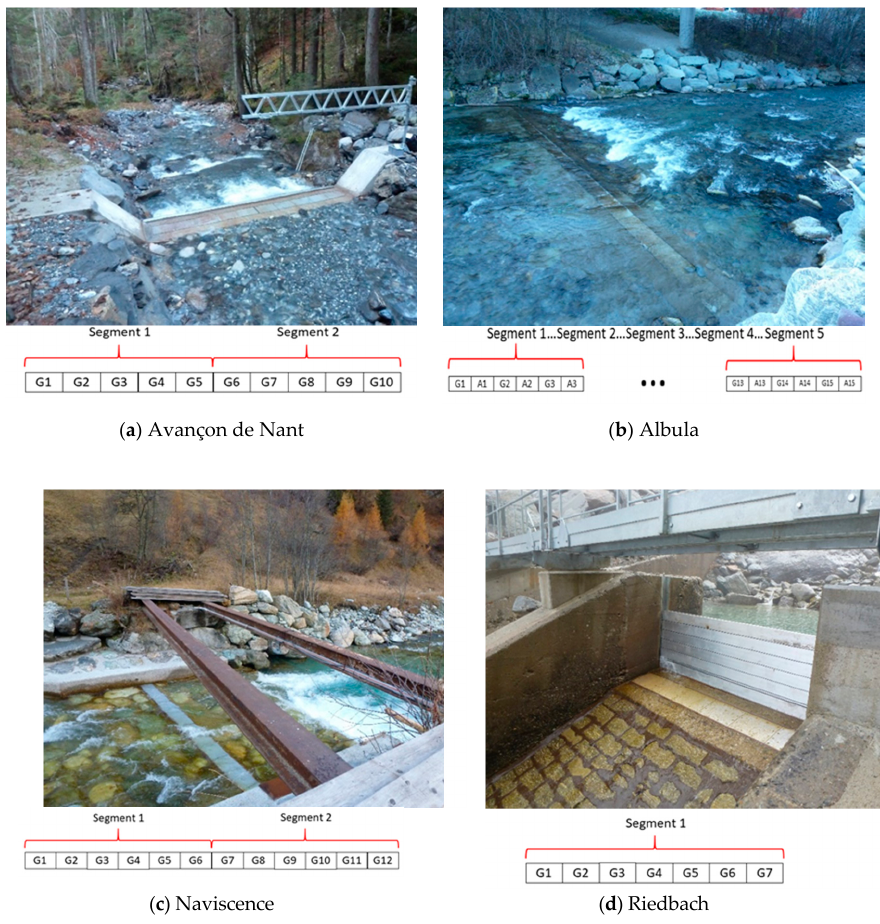
Figure 4. The four measuring stations where the impact experiment was conducted and the setup of the plates and segments: ( a ) at the Avançon de Nant (Western Swiss Alps), ( b ) at the Albula (Eastern Swiss Alps), ( c ) at the Naviscence (Southern Swiss Alps), and ( d ) at the Riedbach (Southern Swiss Alps). The numbers on the plates give the Swiss plate geophone (SPG) number. At the Albula, plates ‘A’ are accelerometer sensors, the others labelled G are SPGs. The numbering is made with view in the downstream flow direction at the Avançon de Nant and Riedbach measuring stations, and the upstream flow direction at the Albula and Naviscence measuring stations.